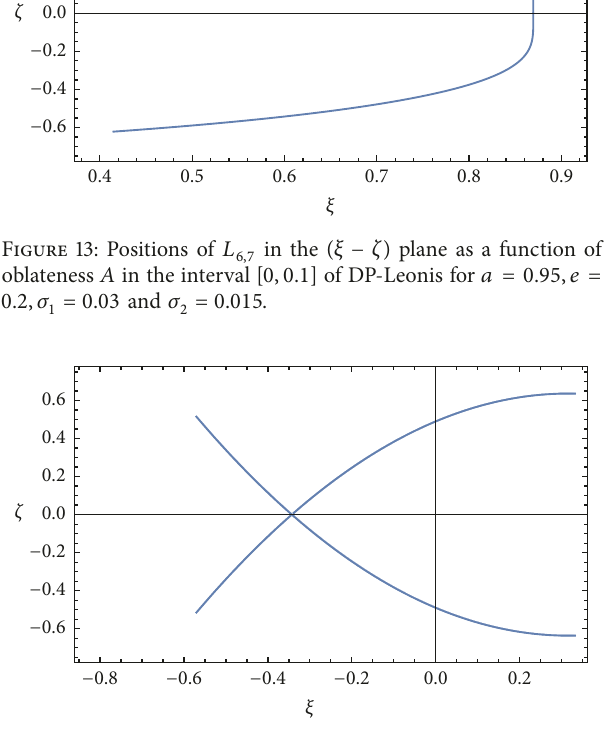
Figure 14: Positions of 𝐿 6,7 in the ( 𝜉 − 𝜁 ) plane as a function of triaxiality 𝜎 1 and 𝜎 2 in the interval [0.01, 0.02] and [0.005, 0.01] , respectively, of DP-Leonis for 𝑎 = 0.95,𝑒 = 0.2 and 𝐴 =